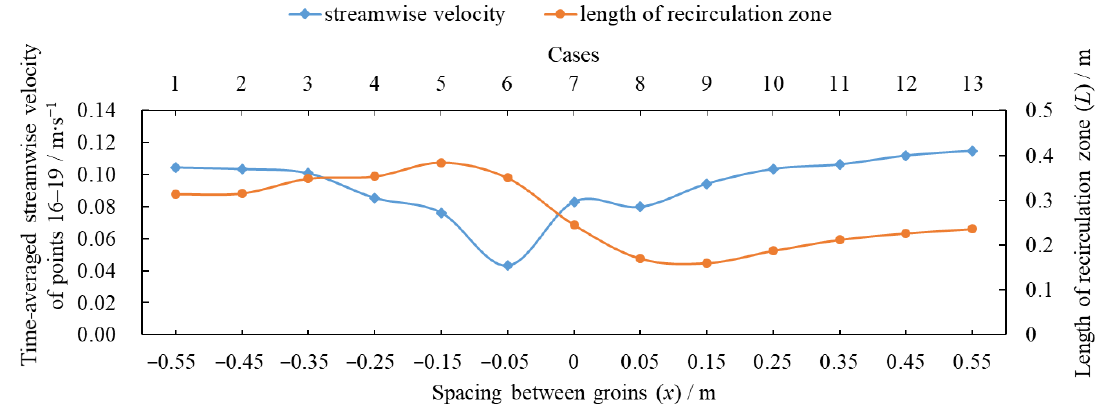
Figure 10. Time-averaged streamwise velocity at observed points (16~19) along the cross-section located at the Groin A tip and the length of the recirculation zone behind Groin A for each case.